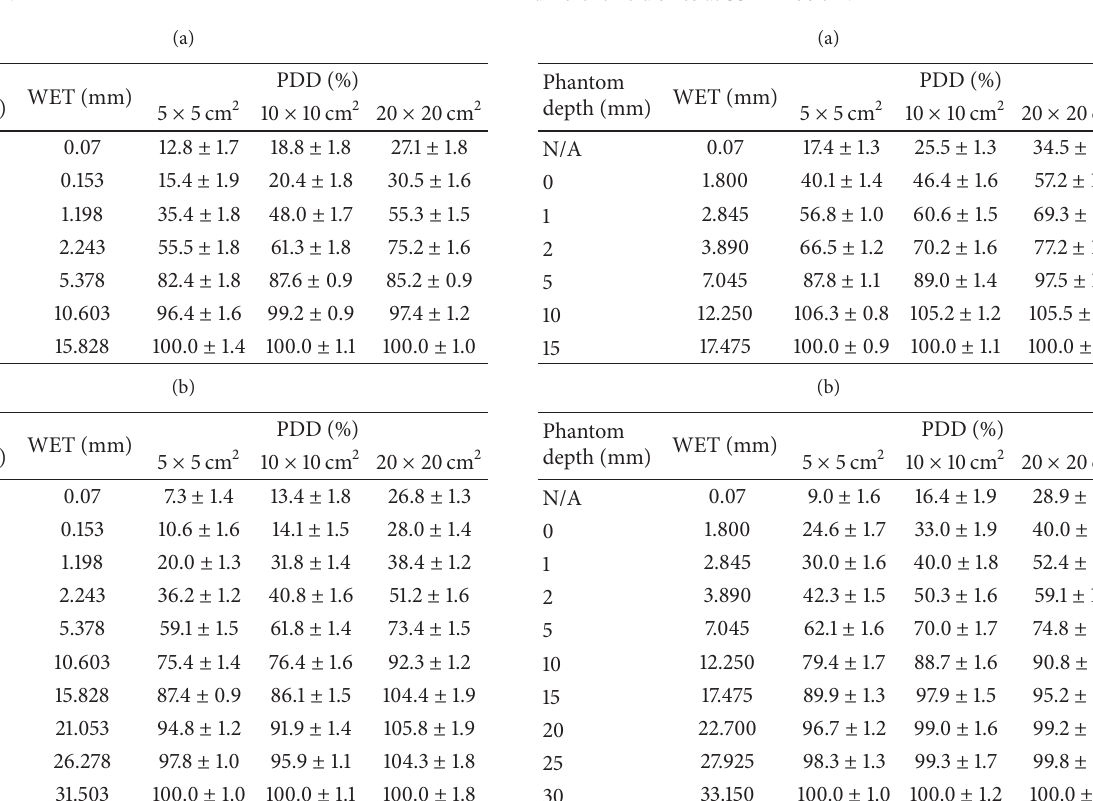
Table 2: (a) Percentage depth doses (PDDs) obtained with EBT3 films in a water equivalent RW3 phantom using 6MV photon beams for different field sizes at SSD = 100 cm. (b) Percentage depth doses (PDDs) obtained with EBT3 films in a water equivalent RW3 phantom using 15 MV photon beams for different field sizes at SSD = 100cm.